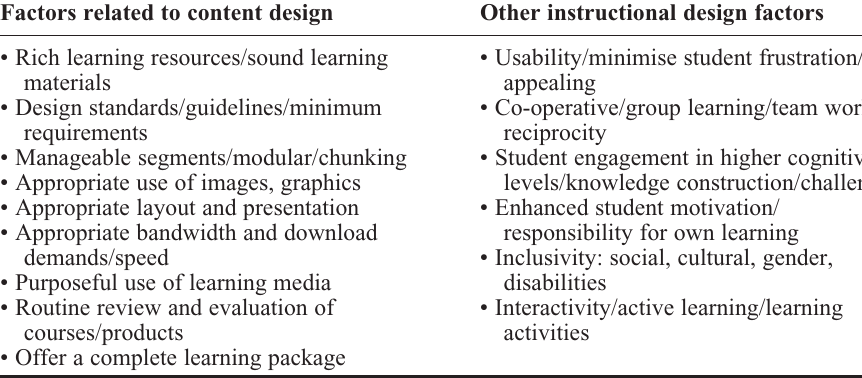
Table 1. Instructional design